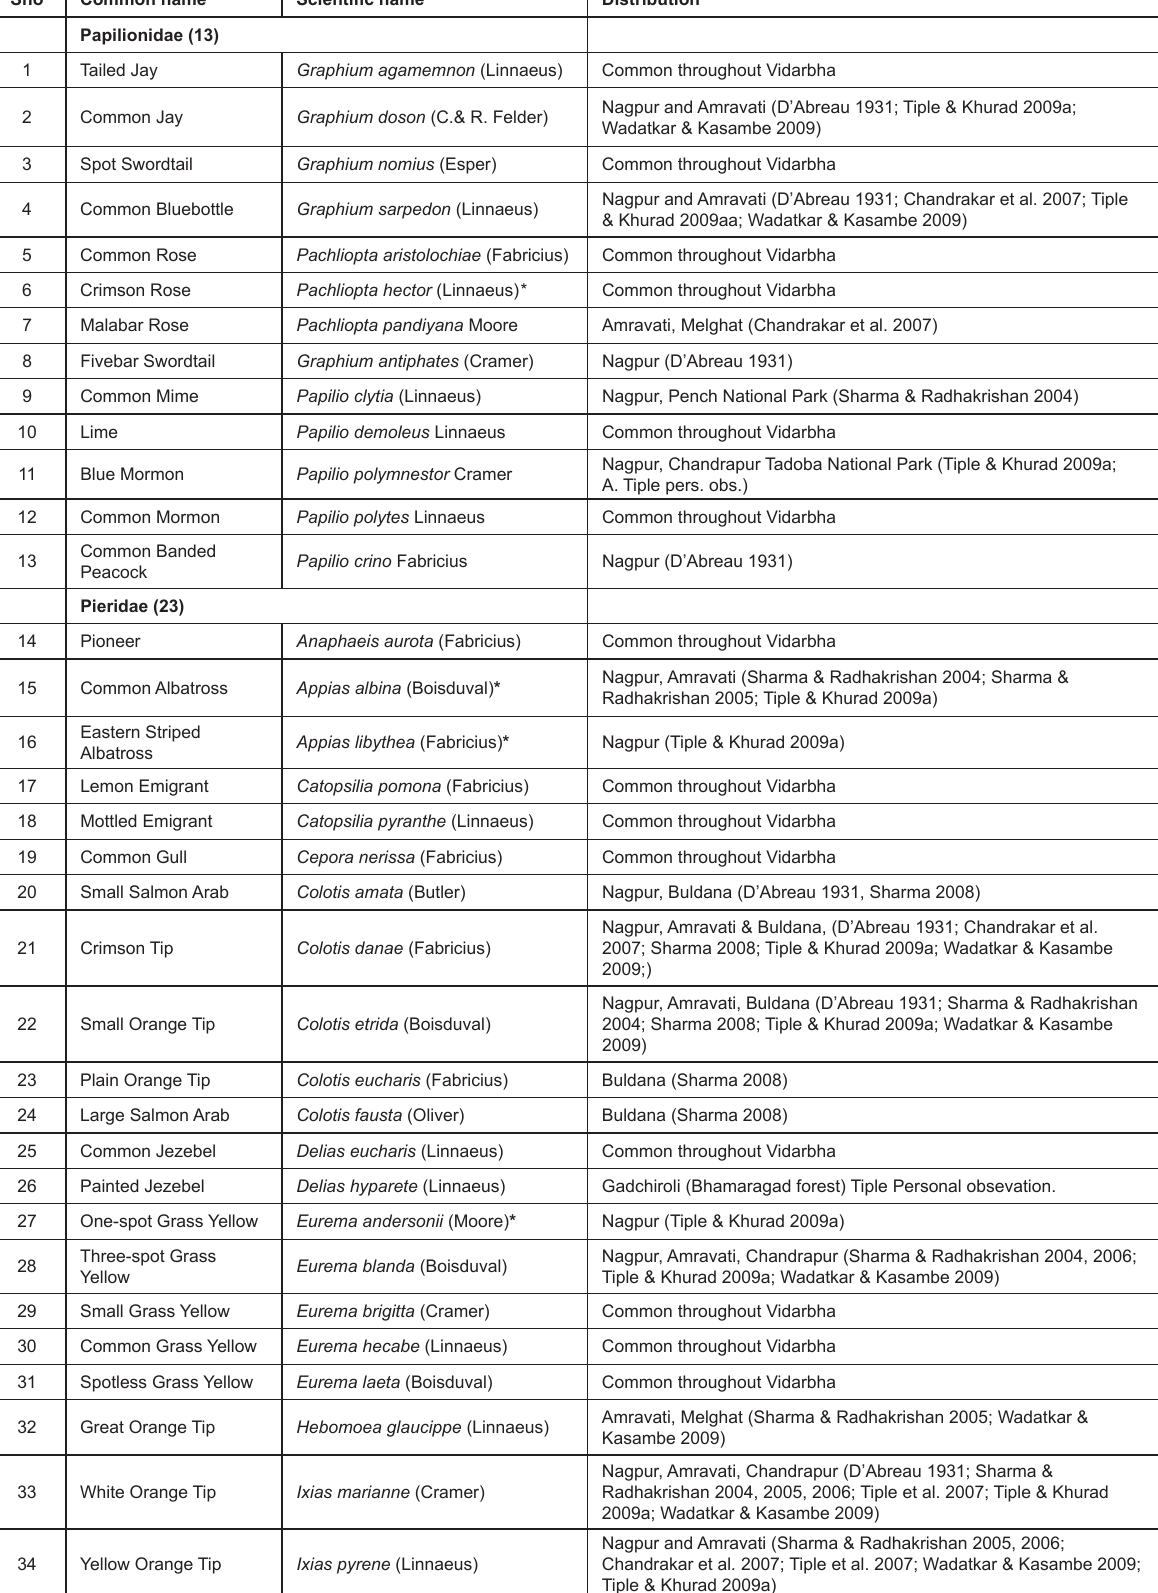
Table 1. List of butterflies recorded from Vidarbha